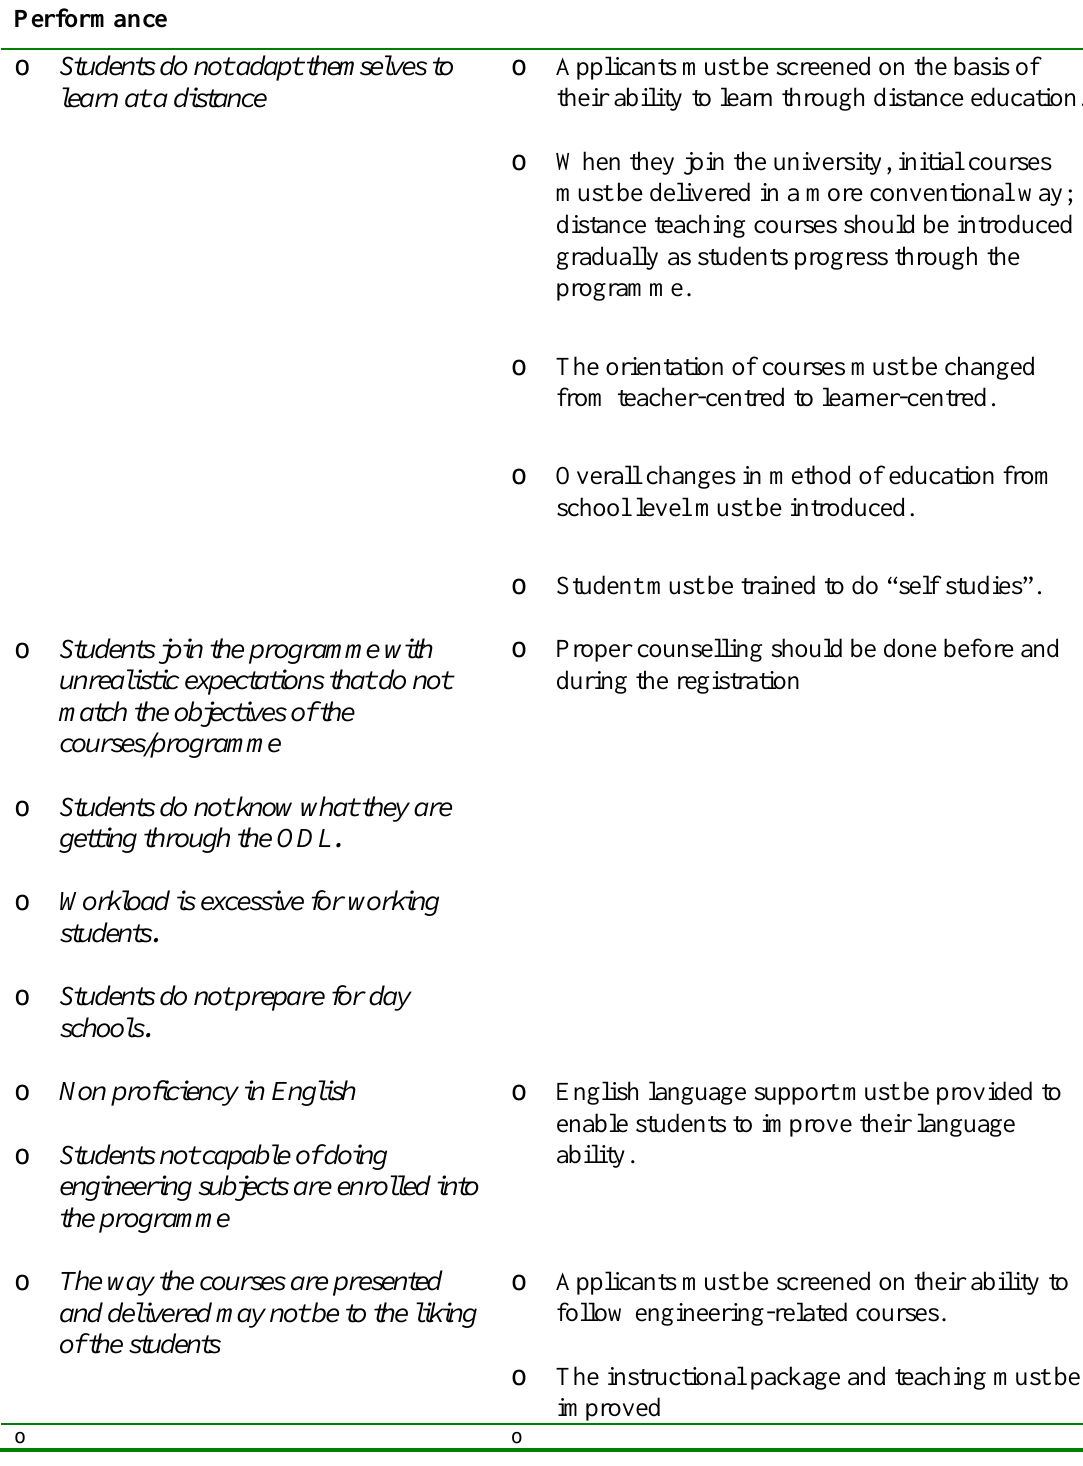
Table 1. Root causes of poor student performance and suggested remedial actions Root causes for Poor Student